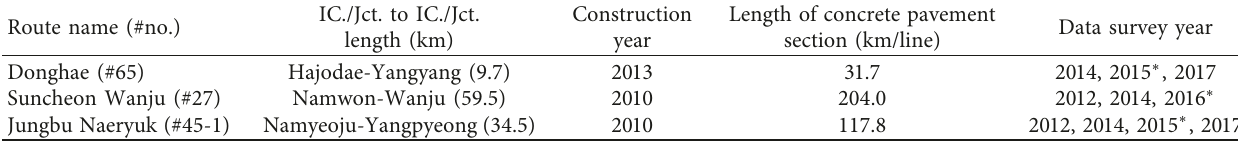
Table 4: Summary of concrete pavement sections built in 2010s for performance data analysis. IC./Jct. to IC./Jct. Route name (#no.)